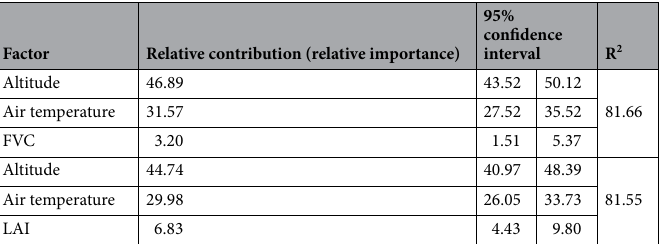
Table 2. Relative contributions of altitude, air temperature, FVC (LAI) to oxygen concentration in the QTP (unit: